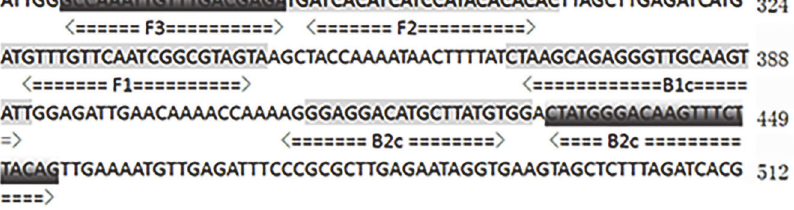
Fig 1. Target sequences of primers for STY2879-LAMP. Nucleotide sequence of STY2879 gene used for designing the inner and outer primers. The outer primers consist of B3 and the sequence (F3) complementary to F3c, respectively. Two inner primers were labeled as forward inner primer (FIP) and the backward inner primer (BIP), respectively, and each contains two distinct sequences corresponding to the sequence and complementary sequence of the target